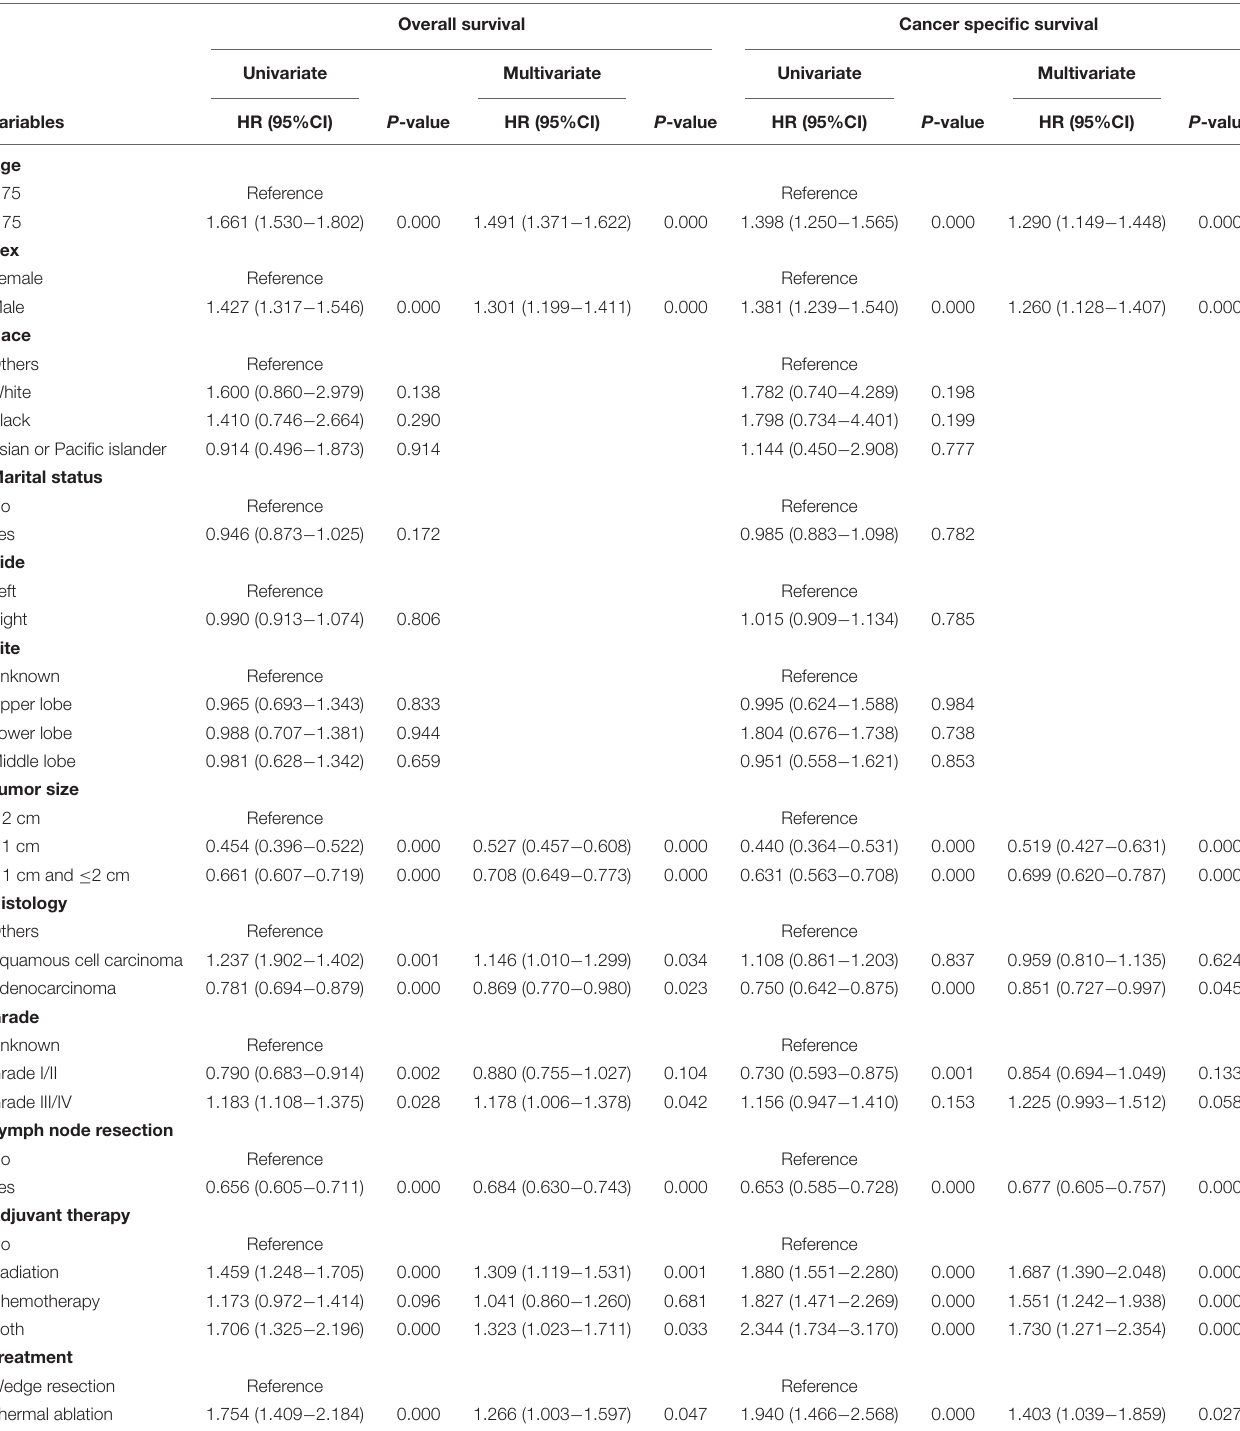
Table 1 . Patients in the thermal ablation group were diagnosed TABLE 2 | Univariate and multivariate Cox regression of OS and CSS in stage I NSCLC patients having thermal ablation and wedge